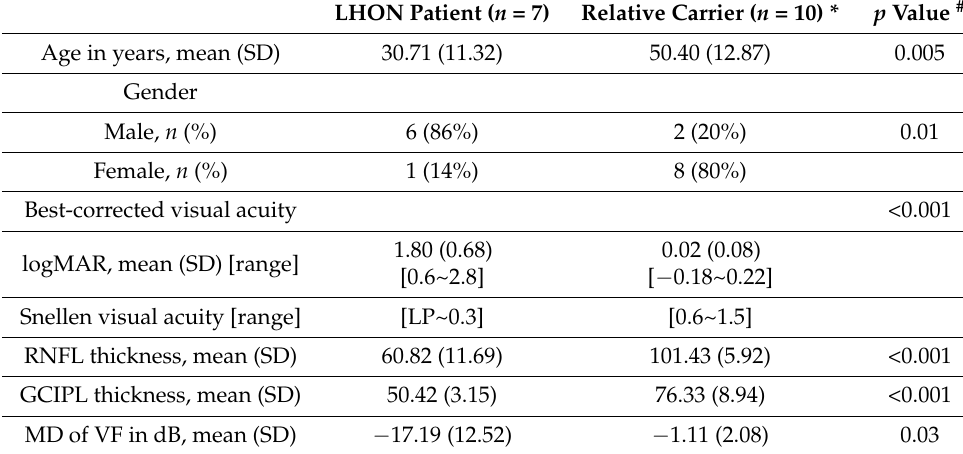
Table 1. The basic characteristics of patients with Leber’s hereditary optic neuropathy (LHON) and their relative carrier with the mitochondrial 11778